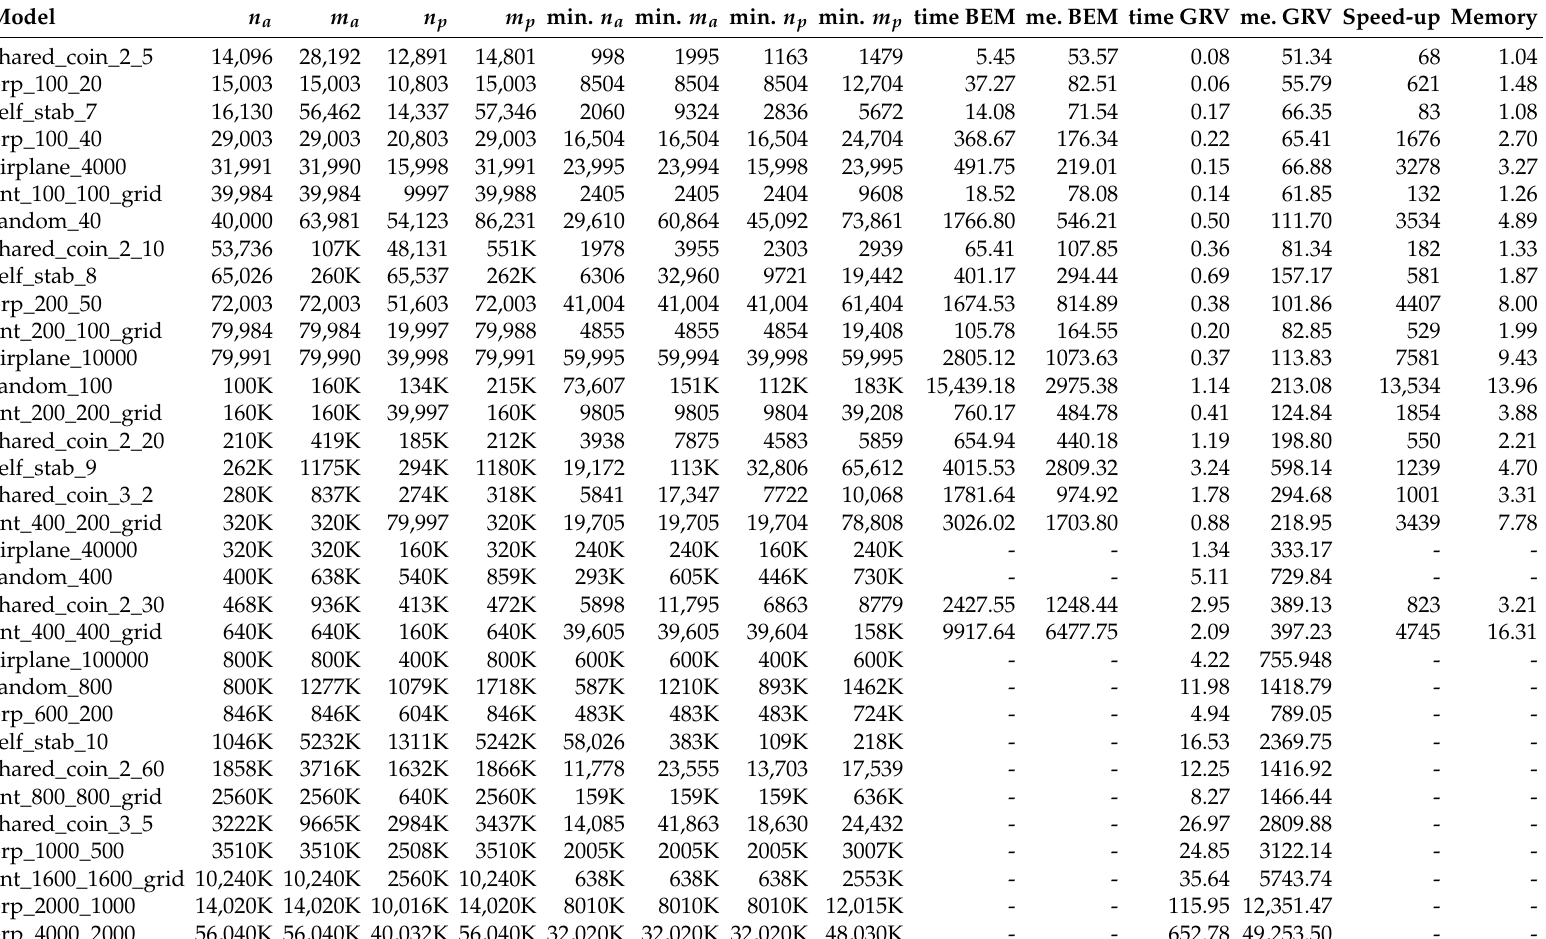
Table 3. Runtime (in s) and memory use (in MB) results for the reference algorithm (BEM) and the GRV algorithm.